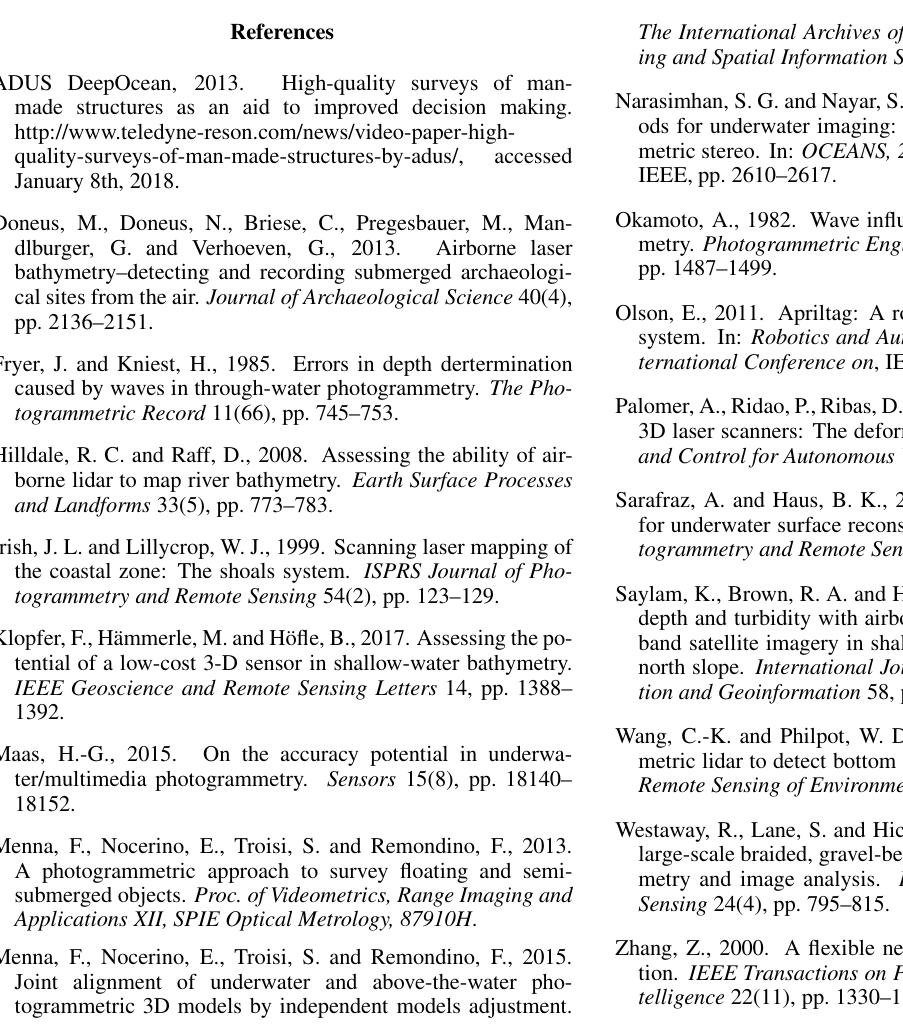
Figure 10. Cross-sections through 3D scans of a wooden pallet. Points below the water are colored in blue and points above the water in red. Starting from the top left with the scanner vertically positioned ( 0 ◦ ), scans with different rotation angles of the structured light scanner are depicted. The last figure, bottom right, shows the cross-section of the reconstruction result after applying the refractive correction method. In the corrected scan the surface of the wooden pallet lines up